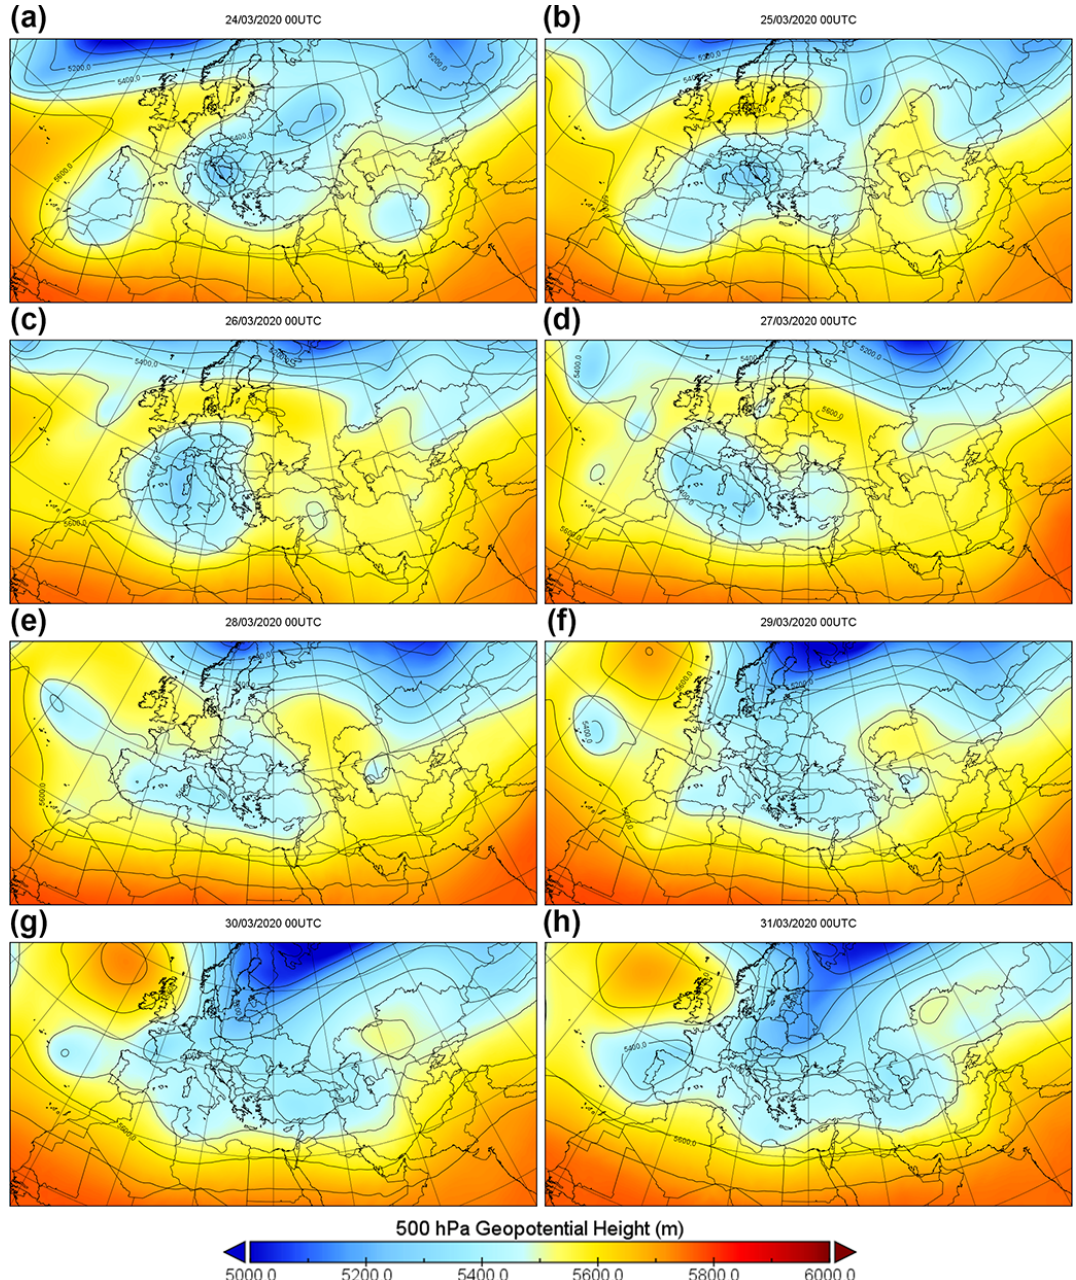
Figure A1. Maps of the geopotential at 500hPa (colors and isolines, in m 2 s − 2 ) relative to each day in the period from 24 to 31 March at 00:00UTC (a–h) . The maps were created with Panoply starting from ERA5 reanalysis. Panels (a) to (h) refer to the respective days from